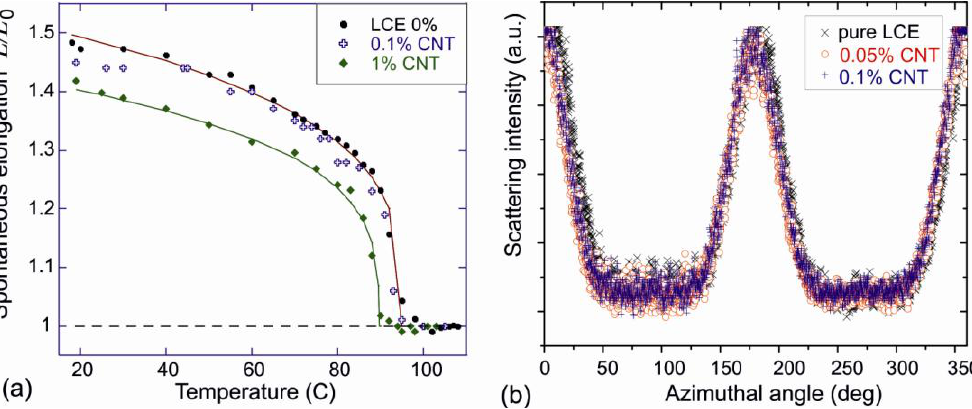
Figure 4. ( a ) The spontaneous length variation with temperature for LCE samples containing differing amounts of CNTs. At small concentrations CNTs do not significantly alter this thermal response ( b ) Azimuthal variation in X-ray intensity for samples containing increasing concentrations of MWCNTs: the addition of a small concentration of CNTs does not affect the internal orientational order of the LCE